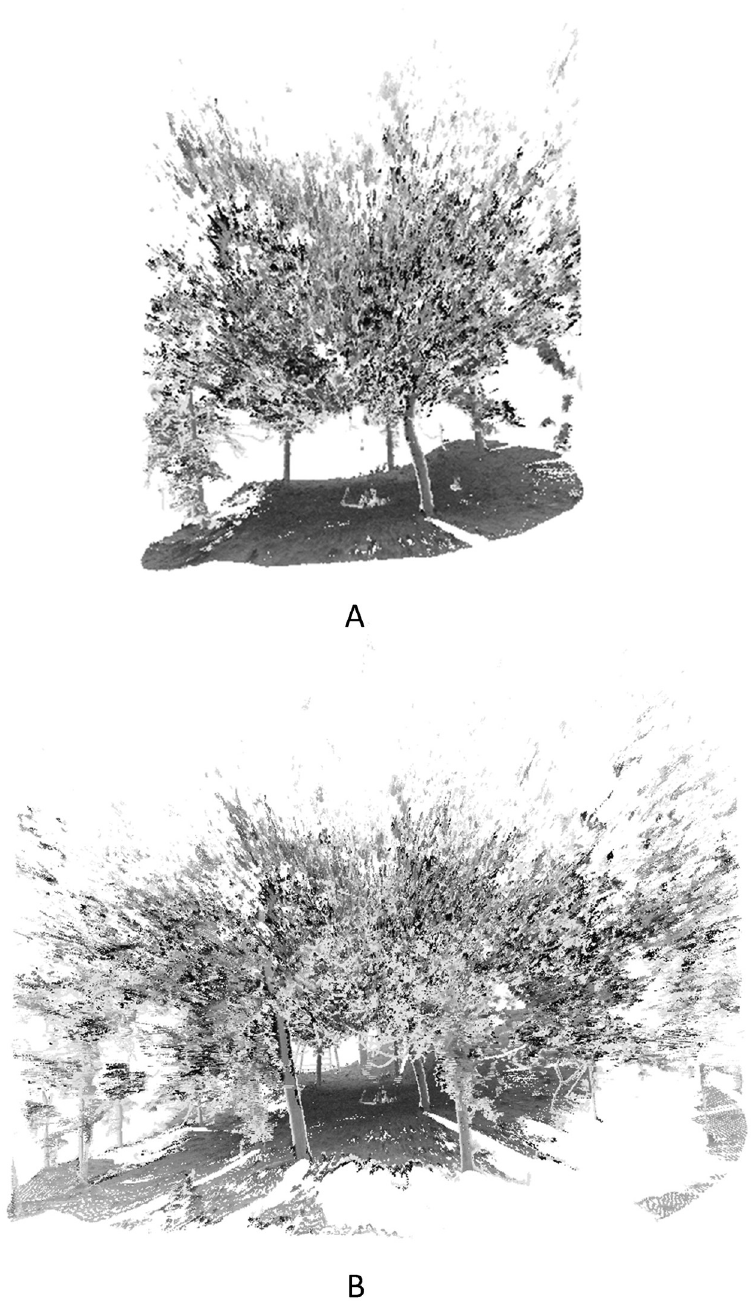
Fig 15. The point cloud data of JiuFeng